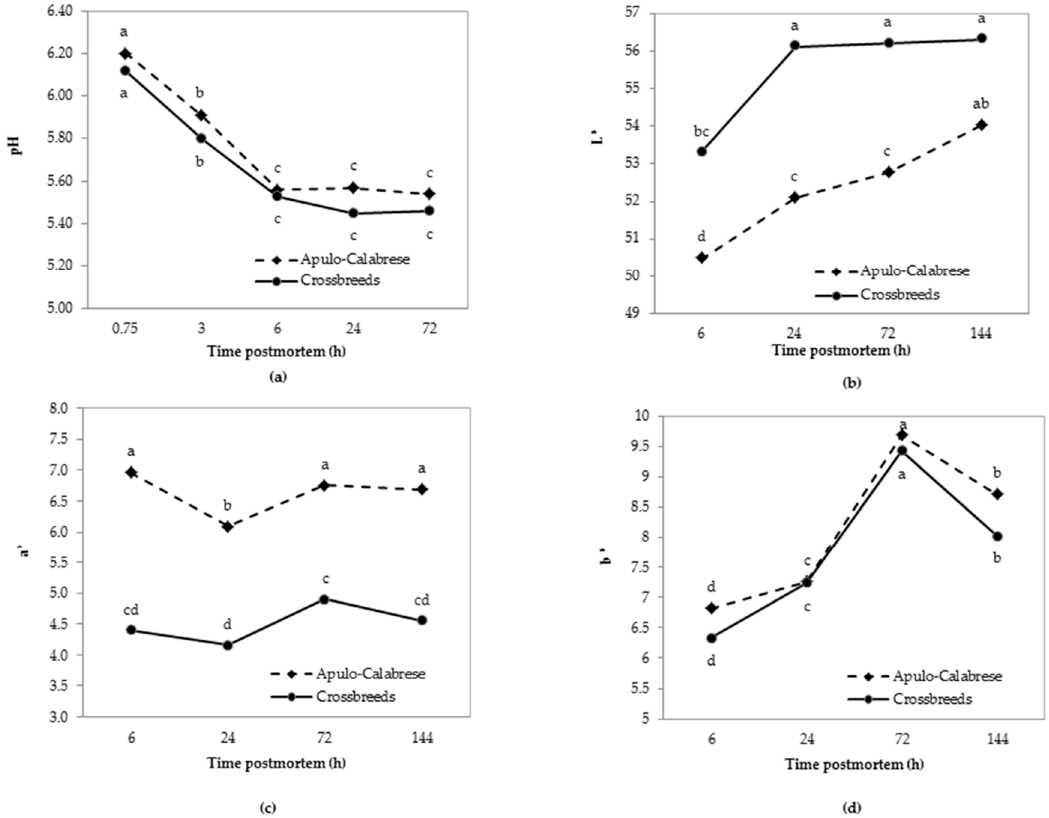
Figure 2. Changes in pH ( a ) and colour coordinates (L* in ( b ), a* in ( c ) and b* in ( d )) in longissimus thoracis in Apulo-Calabrese and crossbreed pigs over time. Different letters in the graphs (a, b, c, d) indicate significant effects ( p < 0.05).